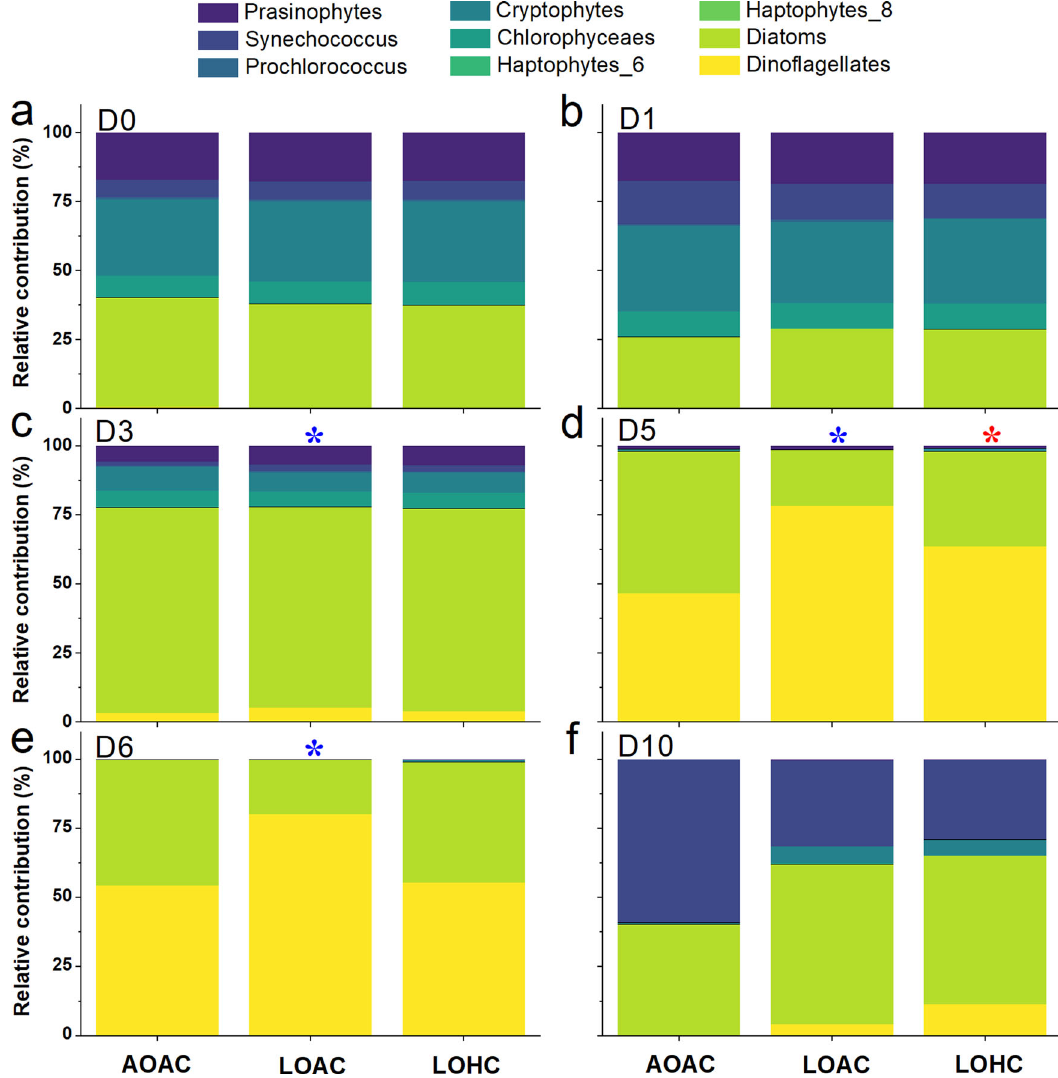
Fig. 4 Taxonomic composition of phytoplankton assemblages in the mesocosms under three different O 2 /CO 2 combinations. Proportions of different major phytoplankton groups are indicated in different colors on ( a ) day 0, ( b ) day 1, ( c ) day 3, ( d ) day 5, ( e ) day 6, and ( f ) day 10 under ambient (AO, ~213 μ M) and low O 2 levels (LO, ~57 μ M) with ambient (AC, ~13 μ M) and elevated CO 2 levels (HC, ~27 μ M). D0 represents the initial time of the experiment (22:00, December 27, 2018). Values represent the means of independent biological replicates ( n = 3 mesocosms). Detailed information for the mesocosms experimental features are given in Supplementary Figs. 1 and 2. Blue * and red * indicate signi fi cant differences in proportions of dino fl agellates ( P < 0.05, LSD test) caused by low O 2 under ambient (LOAC) and elevated CO 2 levels (LOHC), respectively, compared to the control treatment Fig. 4c and Fig. 6a, b, P = 0.0038, P < 0.0001). The ef fi ciency of CO 2 acquisition, expressed here as the quotient of maximal photosynthetic rate ( V max ) to K 0.5 , increased signi fi cantly with decreased O 2 by up to 187%, under the AC level (Fig. 6a, inset, P = 0.0001), but only by about 40% under the HC level (Fig. 6b, inset, P = 0.0481). This implies opposing effects of reduced O 2 and elevated CO 2 (lowered pH) on CO 2 acquisition ef fi ciency.